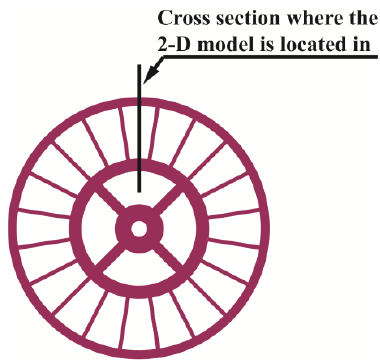
Figure 3. Selection of the plane for the analytical model and the 2-D numerical model.